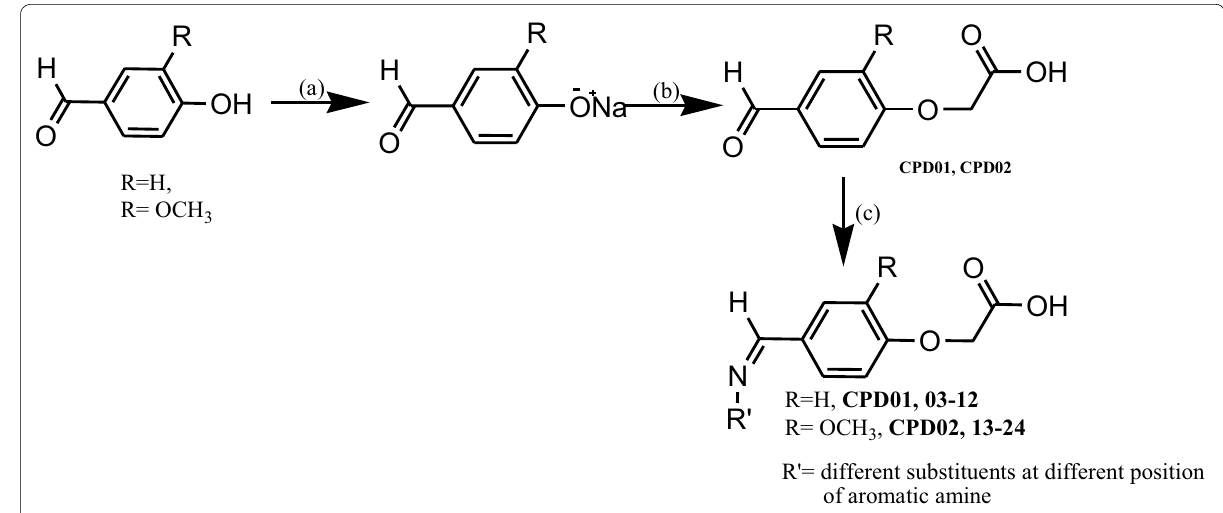
Cytotoxicity results revealed the different cytotoxic concentration levels of synthesized compounds which are in the range of 15.87 to 398.59 µg/ml with respect to the standard pioglitazone (CTC 50 17.56 µg/ml).